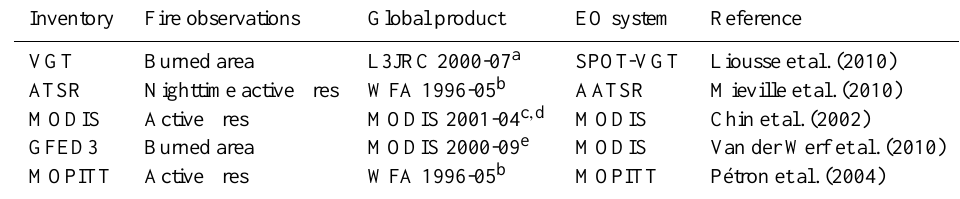
Table 1. Remotely sensed CO emission inventories considered in this analysis for the year 2003. Inventory Fire observations Global product EO